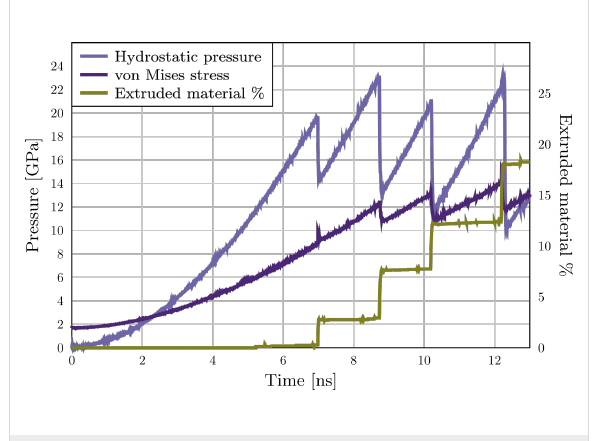
Figure 10: Extrusion from a 11 Å orifice. Hydrostatic pressure, von Mises stress and the amount of extruded material as a function of the simulation time. The nonzero initial value of the von Mises stress is due to the initial shear stresses at the faceted surface of the nano- particle.